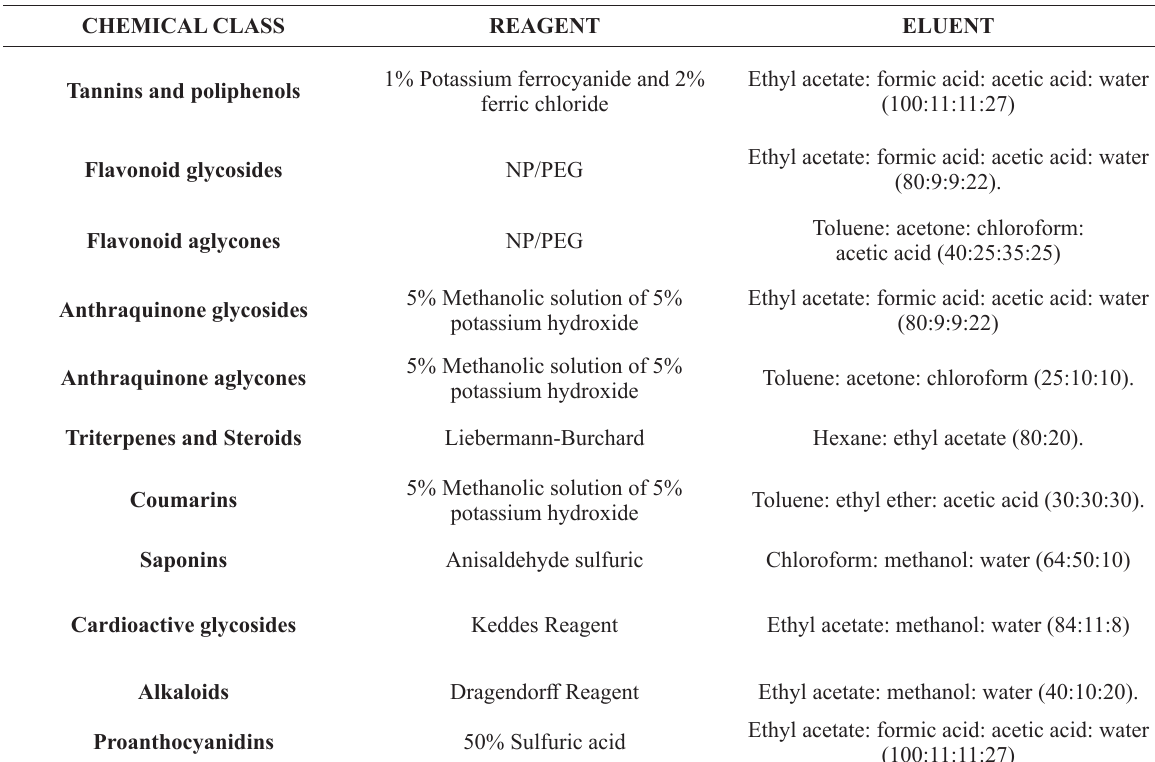
List of reagents used in chemical prospecting tests by TLC (thin layer chromatography) (Farnsworth 1966, Marini- Bettòlo et al. 1981, Wagner et al.